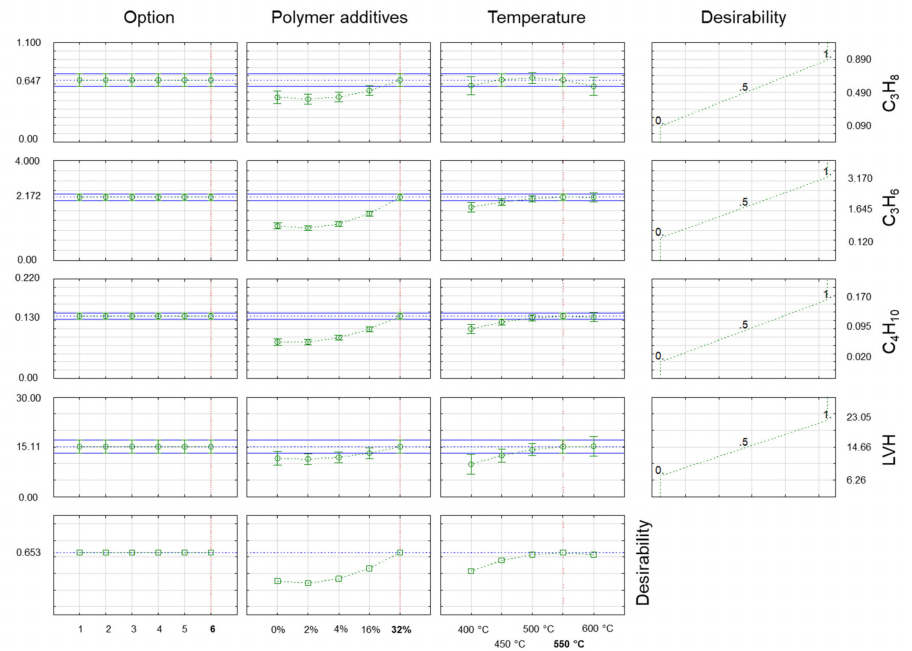
Figure 5. Desirability charts for percentage concentrations (% v / v ) of C 4 H 10 , C 3 H 6 , C 3 H 8 in gaseous products obtained in the optimal co-pyrolysis conditions where desirability was a percentage of target fulfilment (maximisation of essential substances in gaseous products while minimising ballast substances, e.g., CO 2